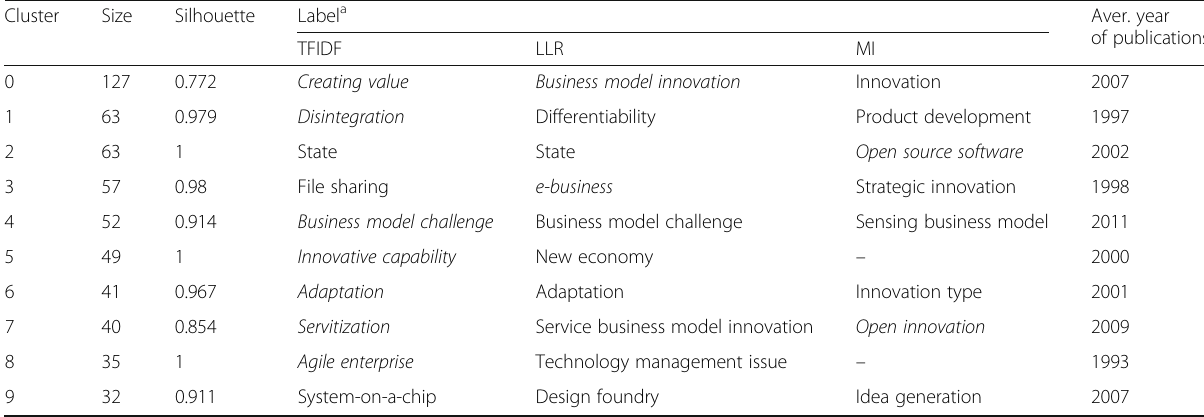
Table 1 TOP 10 clusters of core dataset Cluster Aver. year